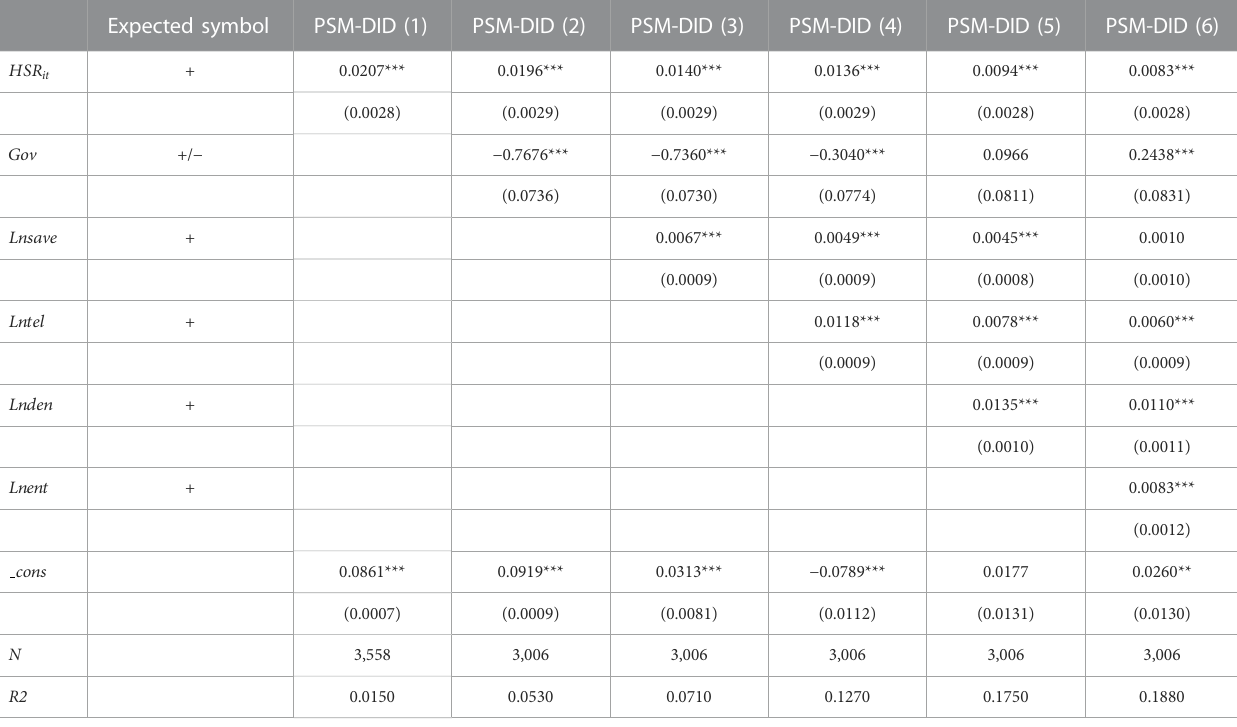
TABLE 7 PSM-DID benchmark regression results.